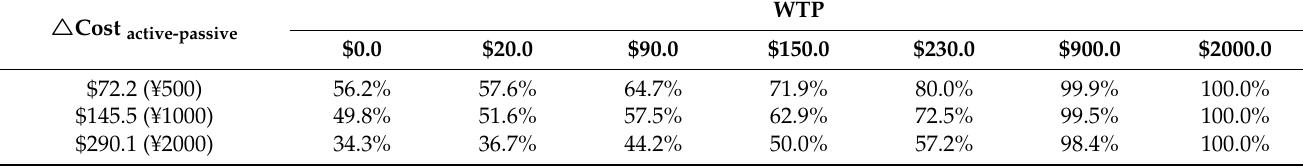
Table 3. Probability of selecting active rather than passive warming under various levels of willingness-to-pay.